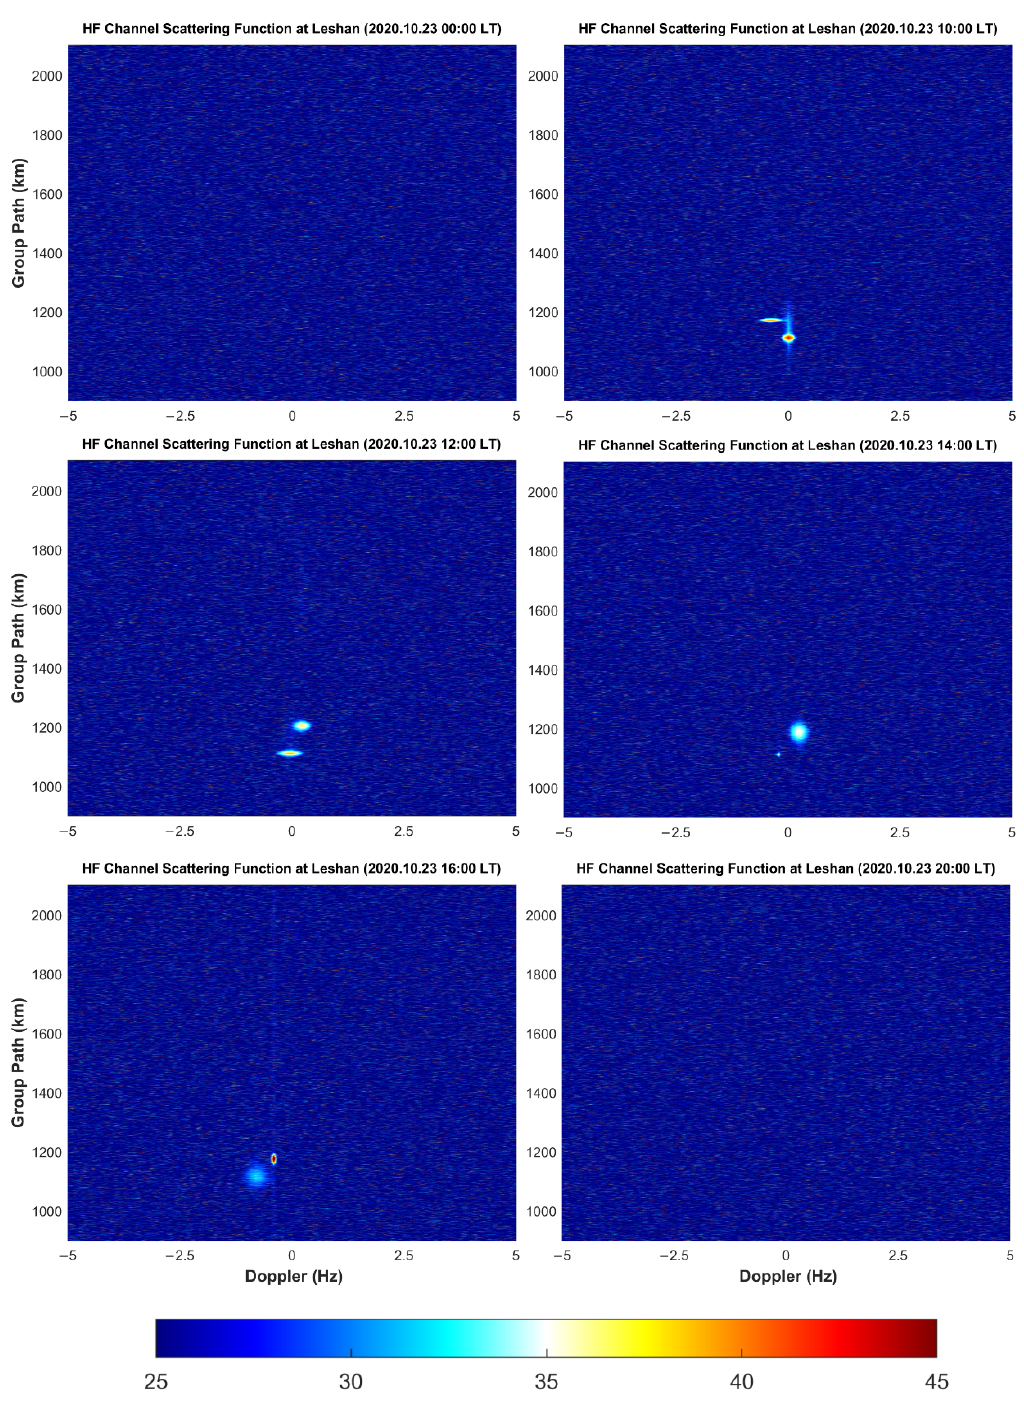
Figure 12. 23 October 2020, modeling and simulation results of the HF channel at Leshan